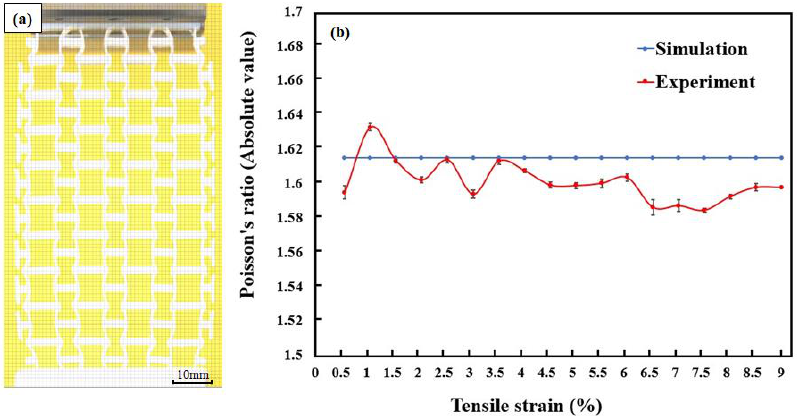
Figure 8. ( a ) Processed image of specimens under tension (strain = 0.09) and ( b ) the changes in Poisson’s